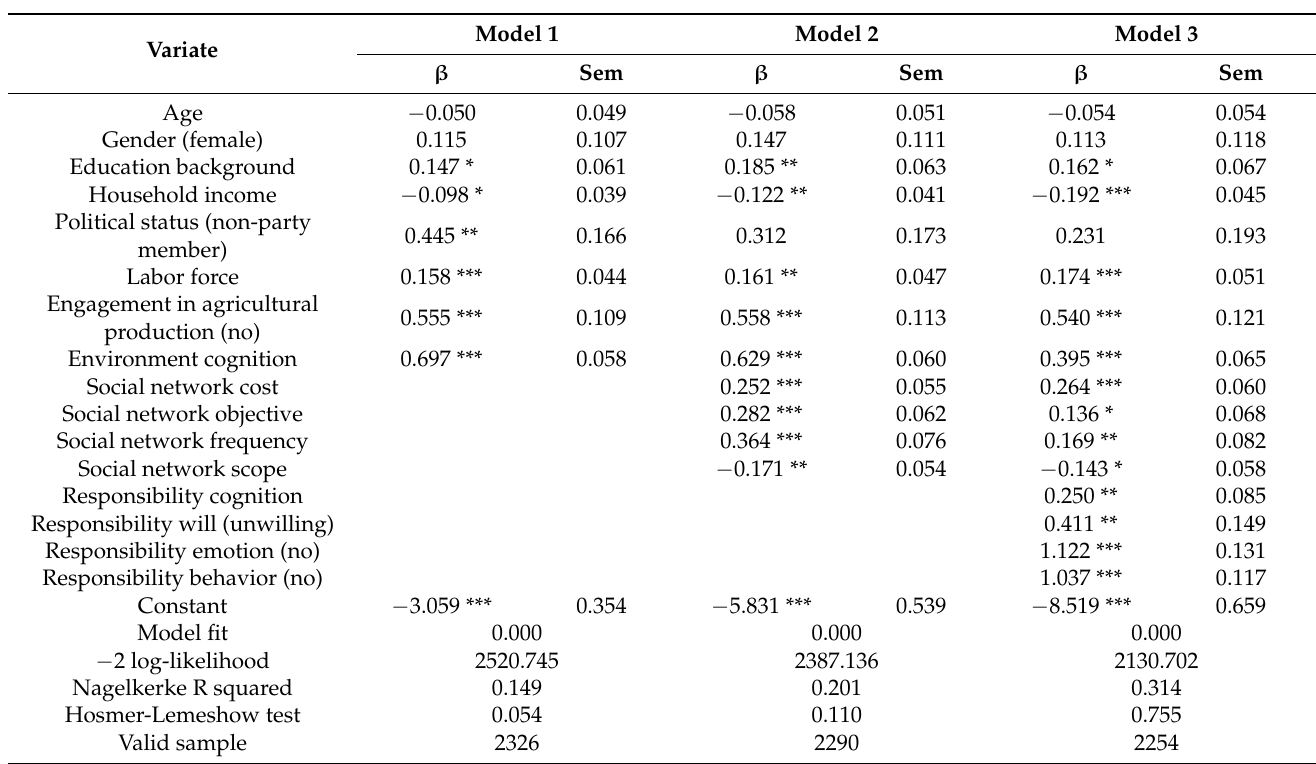
Table 5. Regression analysis of a social network, sense of responsibility and resident participation in rural environmental